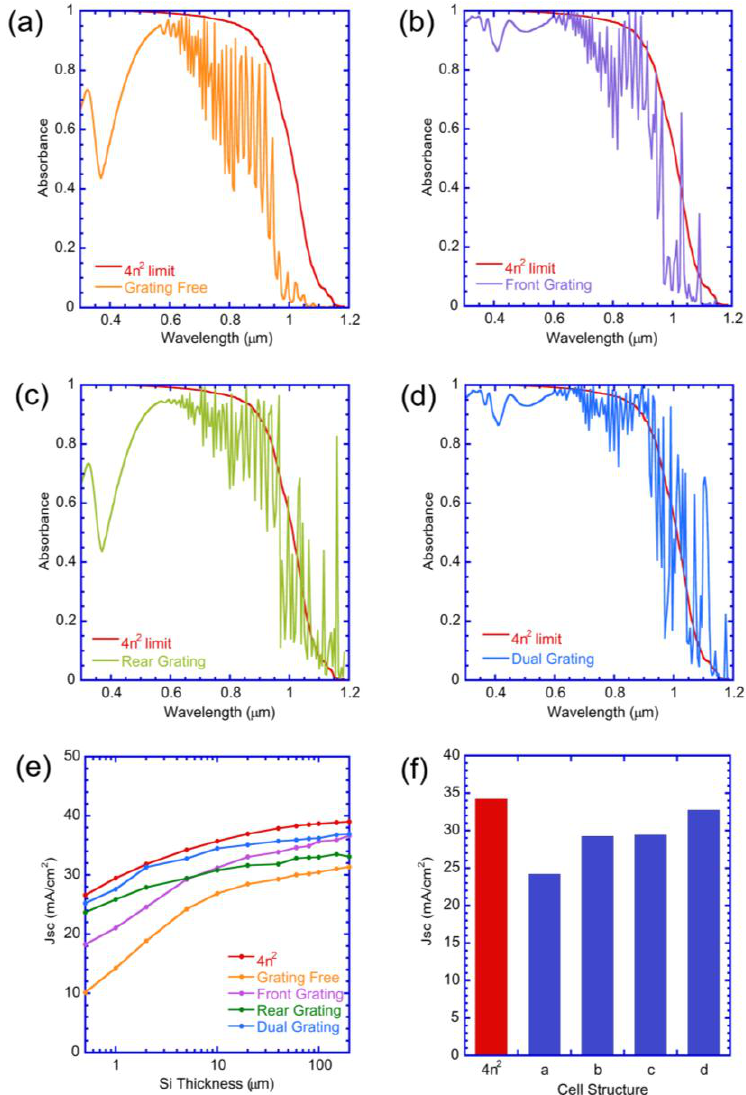
Figure 5. Comparison of absorption spectra of planar silicon with 4 n 2 absorption limit for different light trapping configurations shown in Figure 2 such as ( a ) grating-free cell, ( b ) front-grating cell, ( c ) rear-grating cell , and ( d ) dual-grating cell using the optimized grating parameter for 2 μm silicon; ( e ) Comparison of J SC of planar cell for different light trapping configurations shown in Figure 2 with respect to silicon thickness using optimized grating parameters for 2 μm silicon; ( f ) J SC of the cell for a particular thickness of 2 μm for four different configurations.